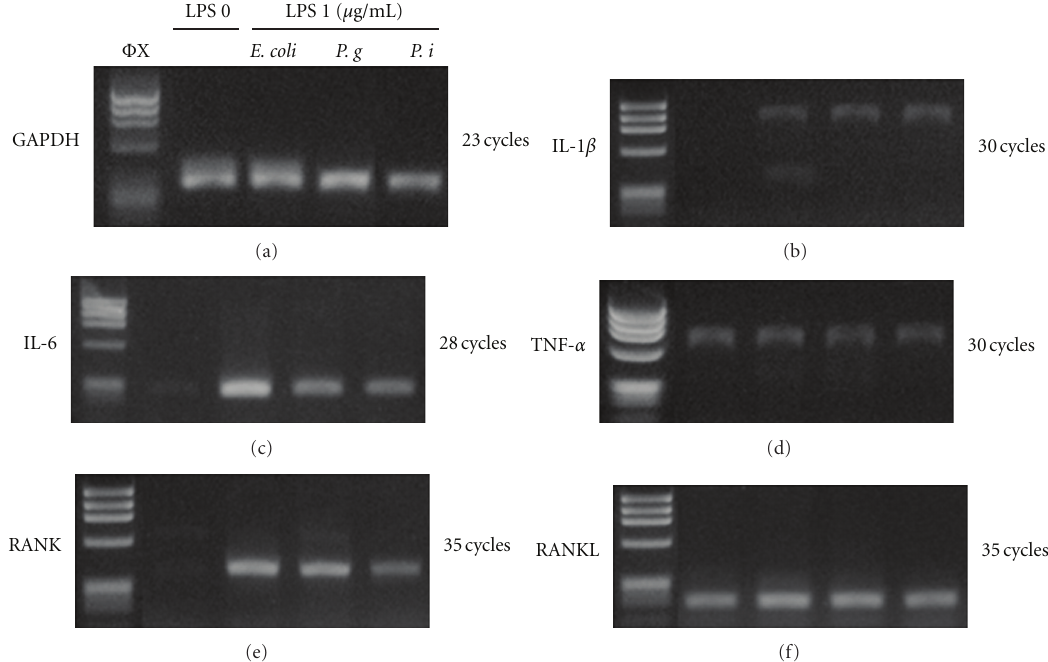
Figure 1: Expression of pro-inflammatory and osteoclastogenic genes with several LPS stimulation in human gingival fibroblasts. IL-1 β , IL-6, TNF- α , RANL, RANKL, and GAPDH gene expression in hGF cultures with di ff erent types of LPS stimulation: E . coli , P . gingivalis , P . intermedia and without LPS for 2 hours. 1 μ g/mL of LPS was used in the experiment. mRNA was isolated at 2 hours. RT-PCR was carried out at di ff erent cycles for each gene. Annealing temperature was 55 degrees for all genes. Table 2: The samples for ELISA analysis were cell-free culture supernatants and protein lysate. Both the cell-free culture supernatant samples and the protein lysate samples of hBMCs and hGFs were obtained from three di ff erent donors and analyzed twice. The cell-free culture supernatant samples of hMO were obtained from one donor. The LPS without samples were analyzed twice and the LPS with samples were analyzed four times. The protein lysate samples were not prepared from